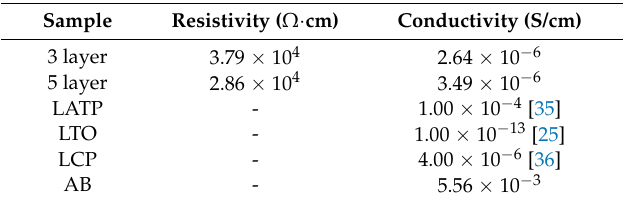
Table 2. Resistivity and conductivities of batteries, conductivities of the constituent materials that make up the battery.